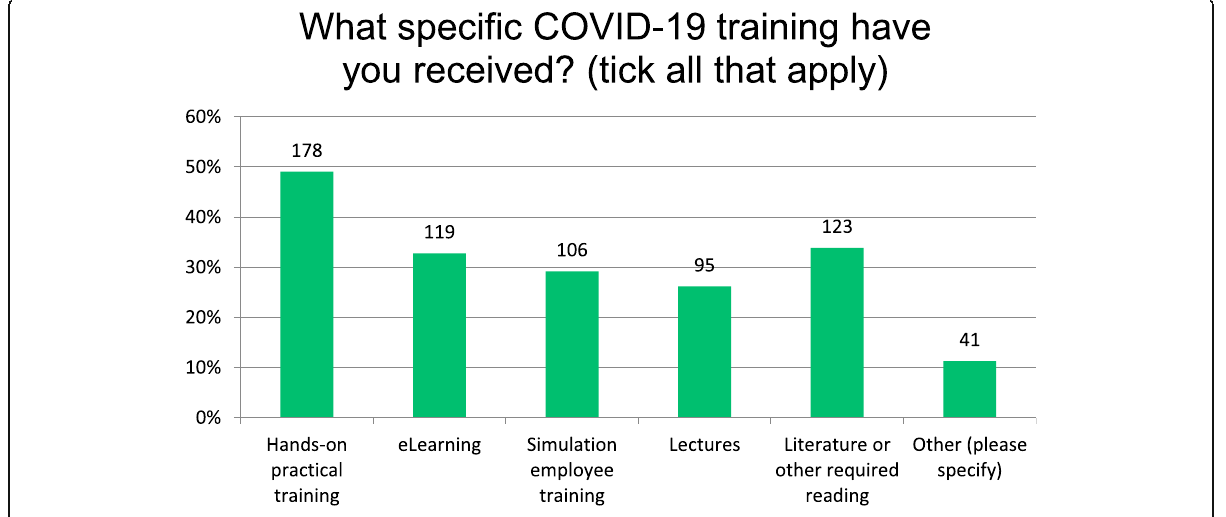
Fig. 2 What specific COVID-19 training respondents received (survey 1)